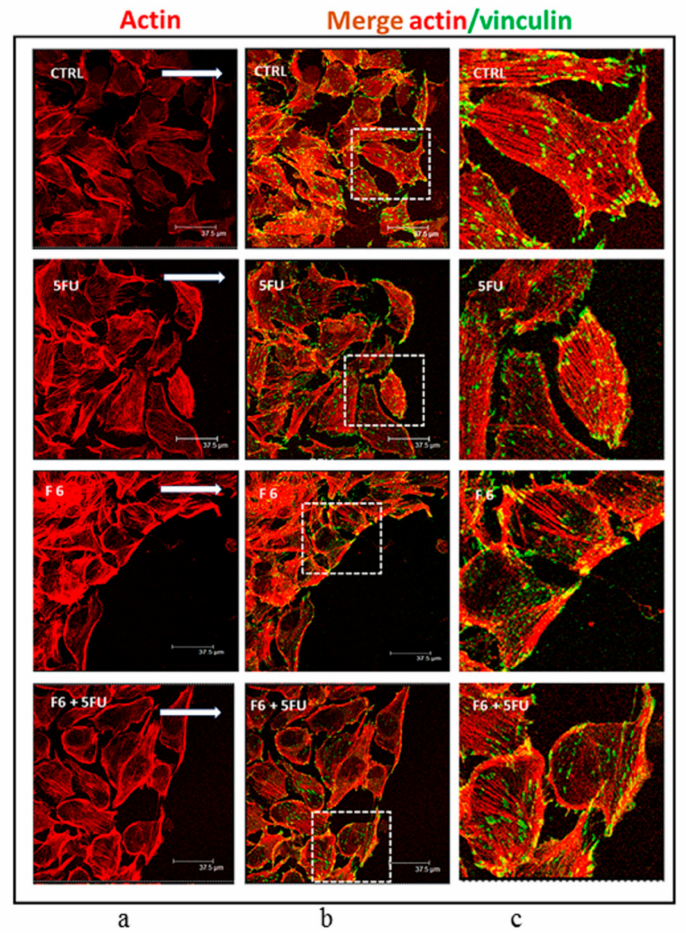
Figure 6. Distribution pattern of vinculin and F-actin in wound-healing assay performed on MDA cells cultured in control condition or exposed to 5FU, F6, and 5FU + F6. Confocal microscopy analysis of F-actin staining with rhodamine-phalloidin (red signal, ( a ) column) merged with anti-vinculin immunofluorescence (FITC / green signal, b column) on MDA cells subjected to wound healing assay, and cultured with or without 5FU, F6, 5FU + F6. The white arrows in the images of the left column indicate the direction of cellular movement toward the gap. In column ( c ) we reported higher magnification of the merging pictures shown in column ( b